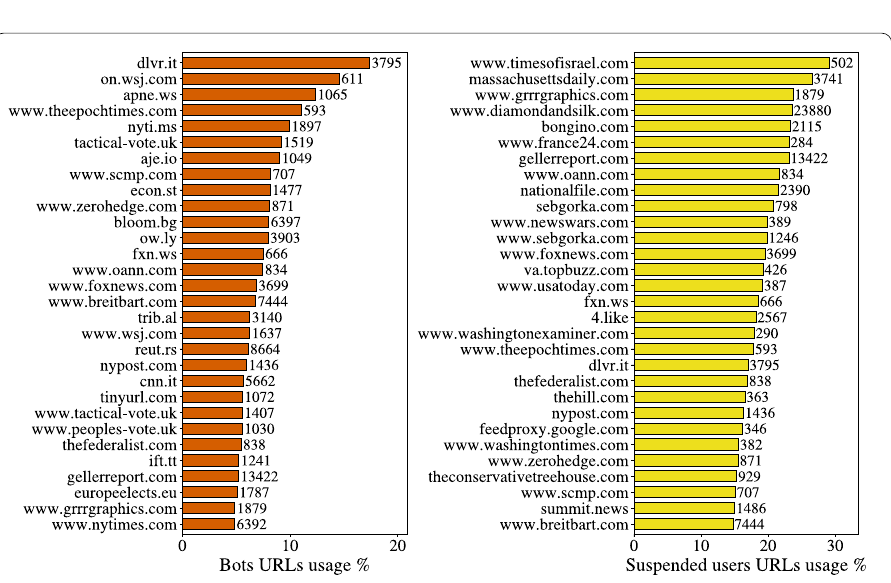
Figure 8 Most retweeted URLs by bots and suspended users in percentage. The percentages are calculated over all users’ URL’s usage. The numbers on the right side of the bars represent the total number of retweets